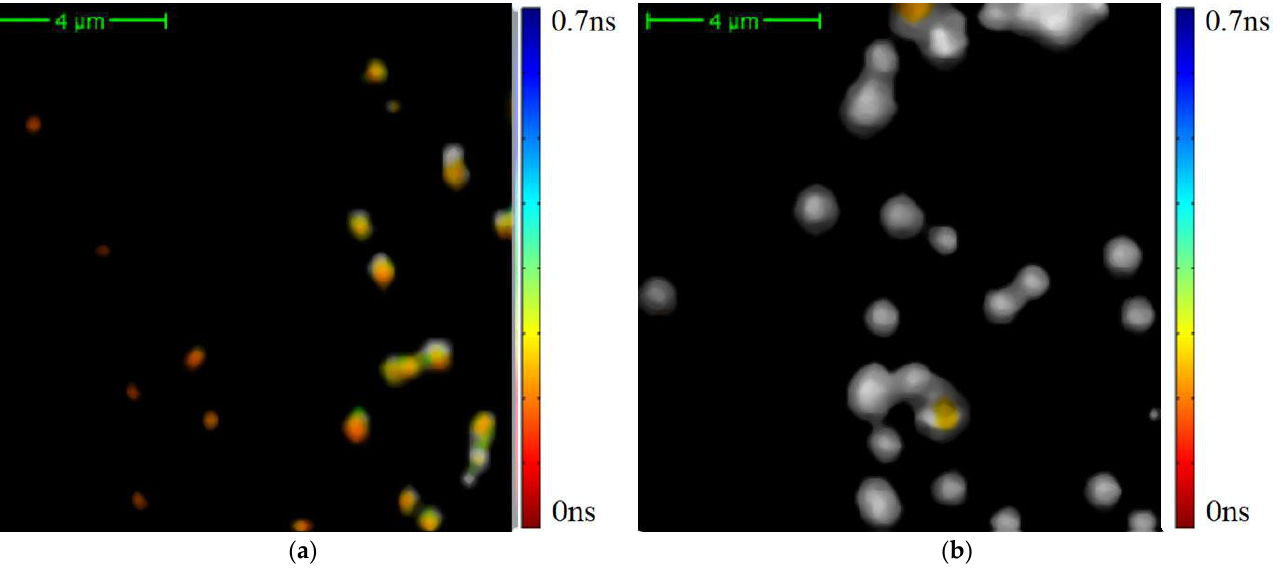
Figure 7. The differentiation of exosomes on the classes described by Formulas (6) and (7). Here, color data points correspond to the exosomes with short average TPAF lifetimes and gray data points correspond to the exosomes with long average TPAF lifetimes. These images are presented unprocessed in Figure 4.